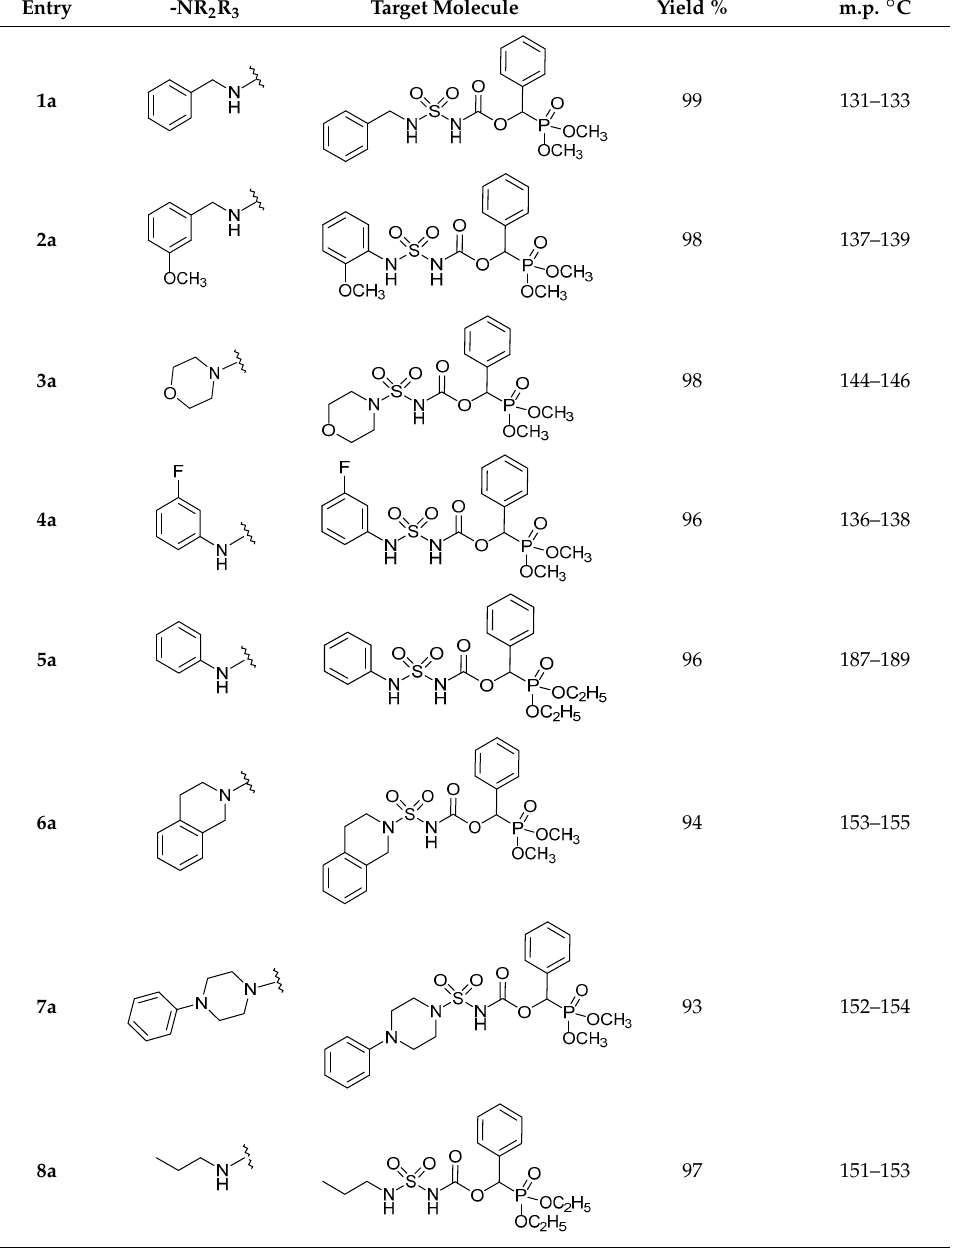
Table 2. Physical data and yields for sulfamidocarbonyloxyphosphonates 1b – 3b synthesized from amino acid esters.